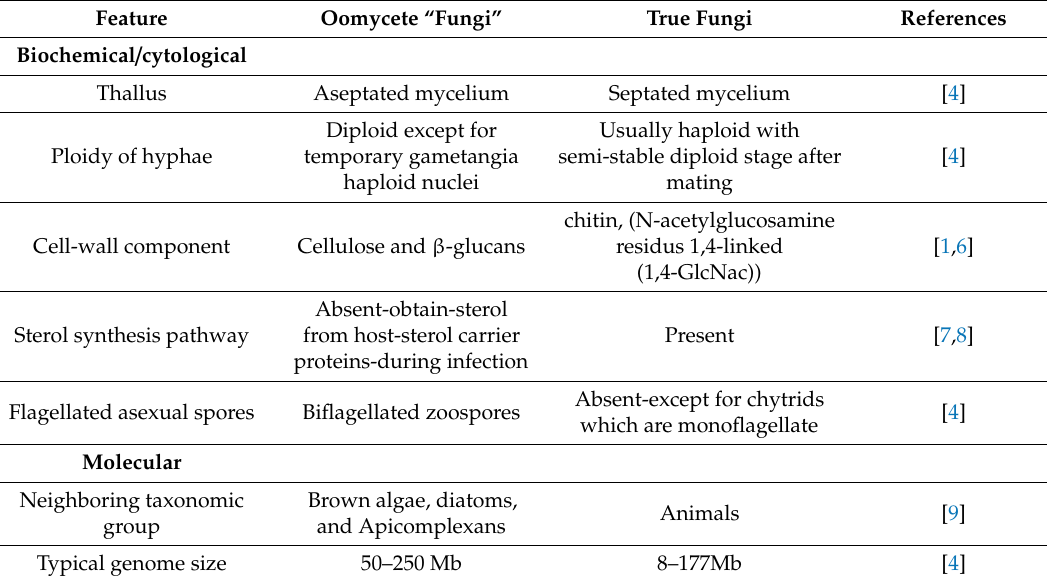
Table 1. Di ff erences between true fungi and